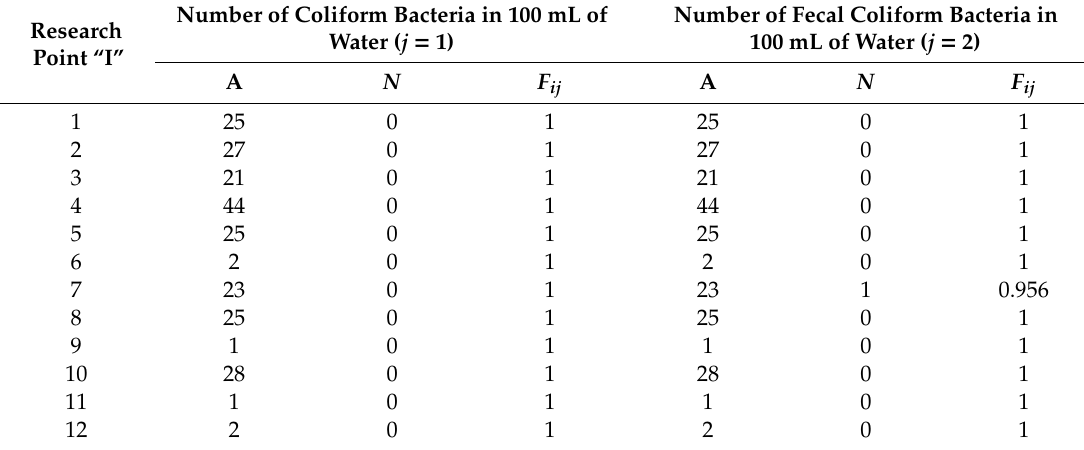
Table 2. Estimation of empirical probability estimators F ij of the normative value of the j th Table 1. (Normative) values of microbiological water quality parameters according to WHO microbiological parameter of water quality at the i th research point according to WHO Guidelines[48] used in the calculation example.